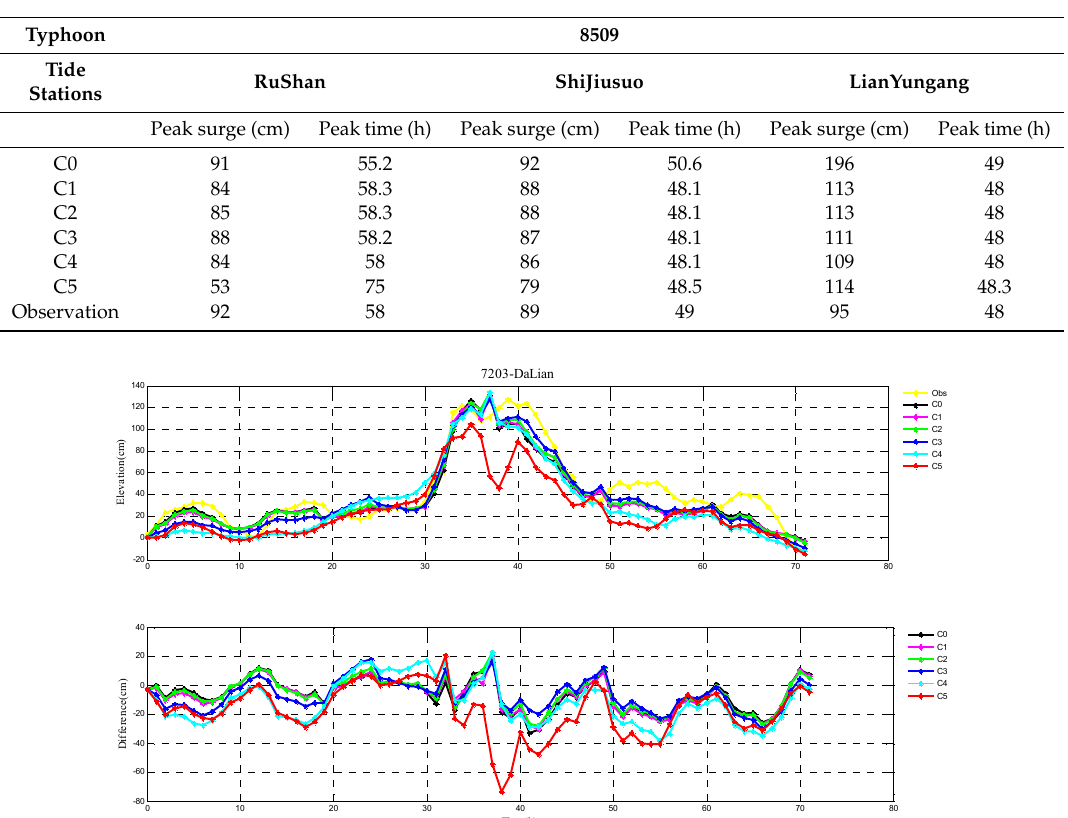
Figure 3. The storm surge elevations (cm) in six cases (C0, C1, C2, C3, C4, C5) and observations (yellow line) (top) and the differences between them (bottom) during Typhoon 7203 at HuLuDao tide station. .